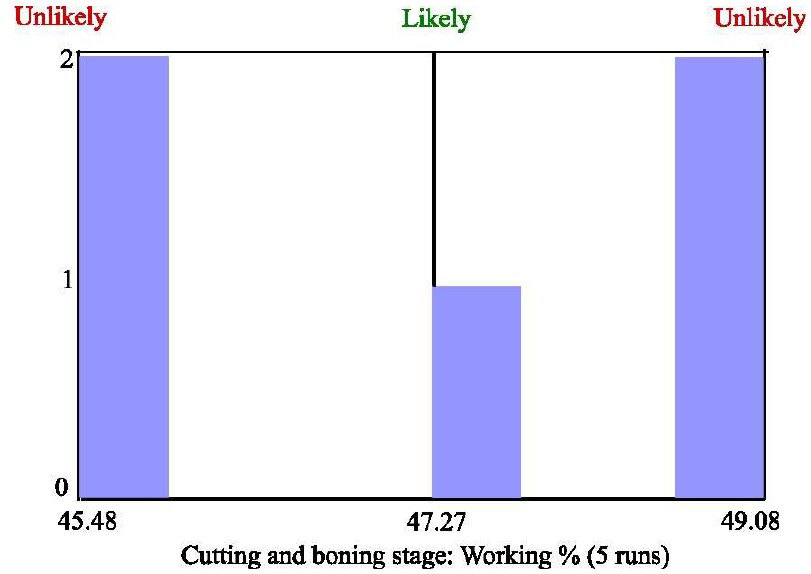
Figure 6. MORE plot for working% in the cutting and boning